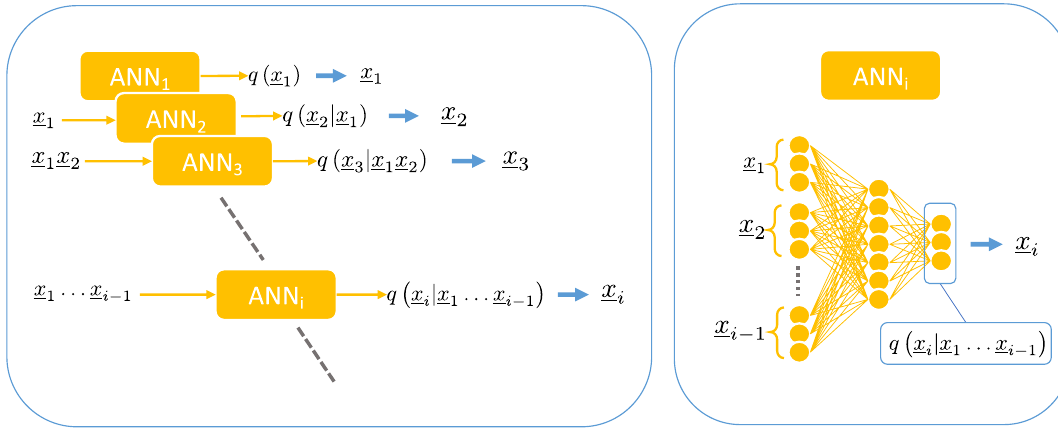
Figure 2. Ancestral sampling of epidemic cascades. Left. Ancestral sampling of epidemic cascades using artificial neural networks. For each individual i there is a neural network ANN i that computes the probability q x i | x i − 1 . . . x 1 of its time trajectory x i given the time trajectory of previous individuals. The time trajectory (cid:30) (cid:31) x i is extracted from the conditional probability q x i | x i − 1 . . . x 1 and passed to the following neural networks. (cid:30) (cid:31) Right. Each neural network is composed of several fully connected layers (see supplementary material for